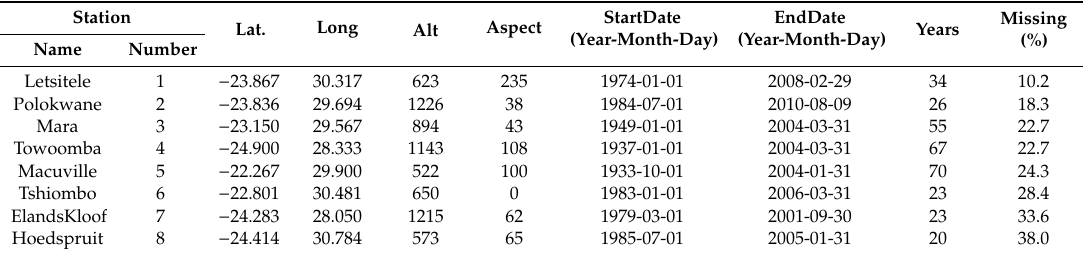
Figure 1. Spatial distribution and topographical variation of target and neighboring stations used to evaluate methods of infilling temperature data in Limpopo Province. Table 1. Geographical and data information of eight of target stations used to evaluate methods of infilling temperature data in Limpopo